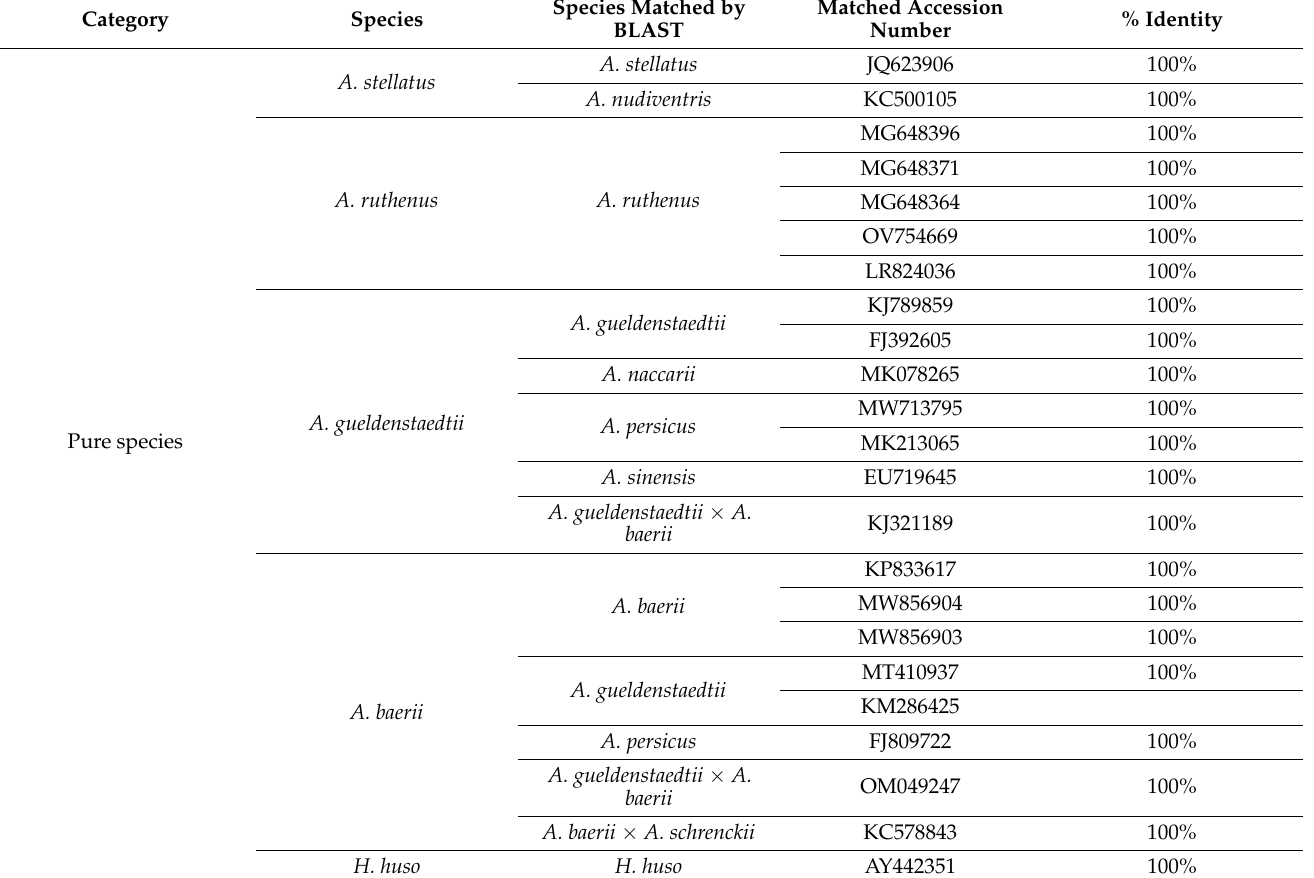
Table 5. List of GenBank screening results generated by